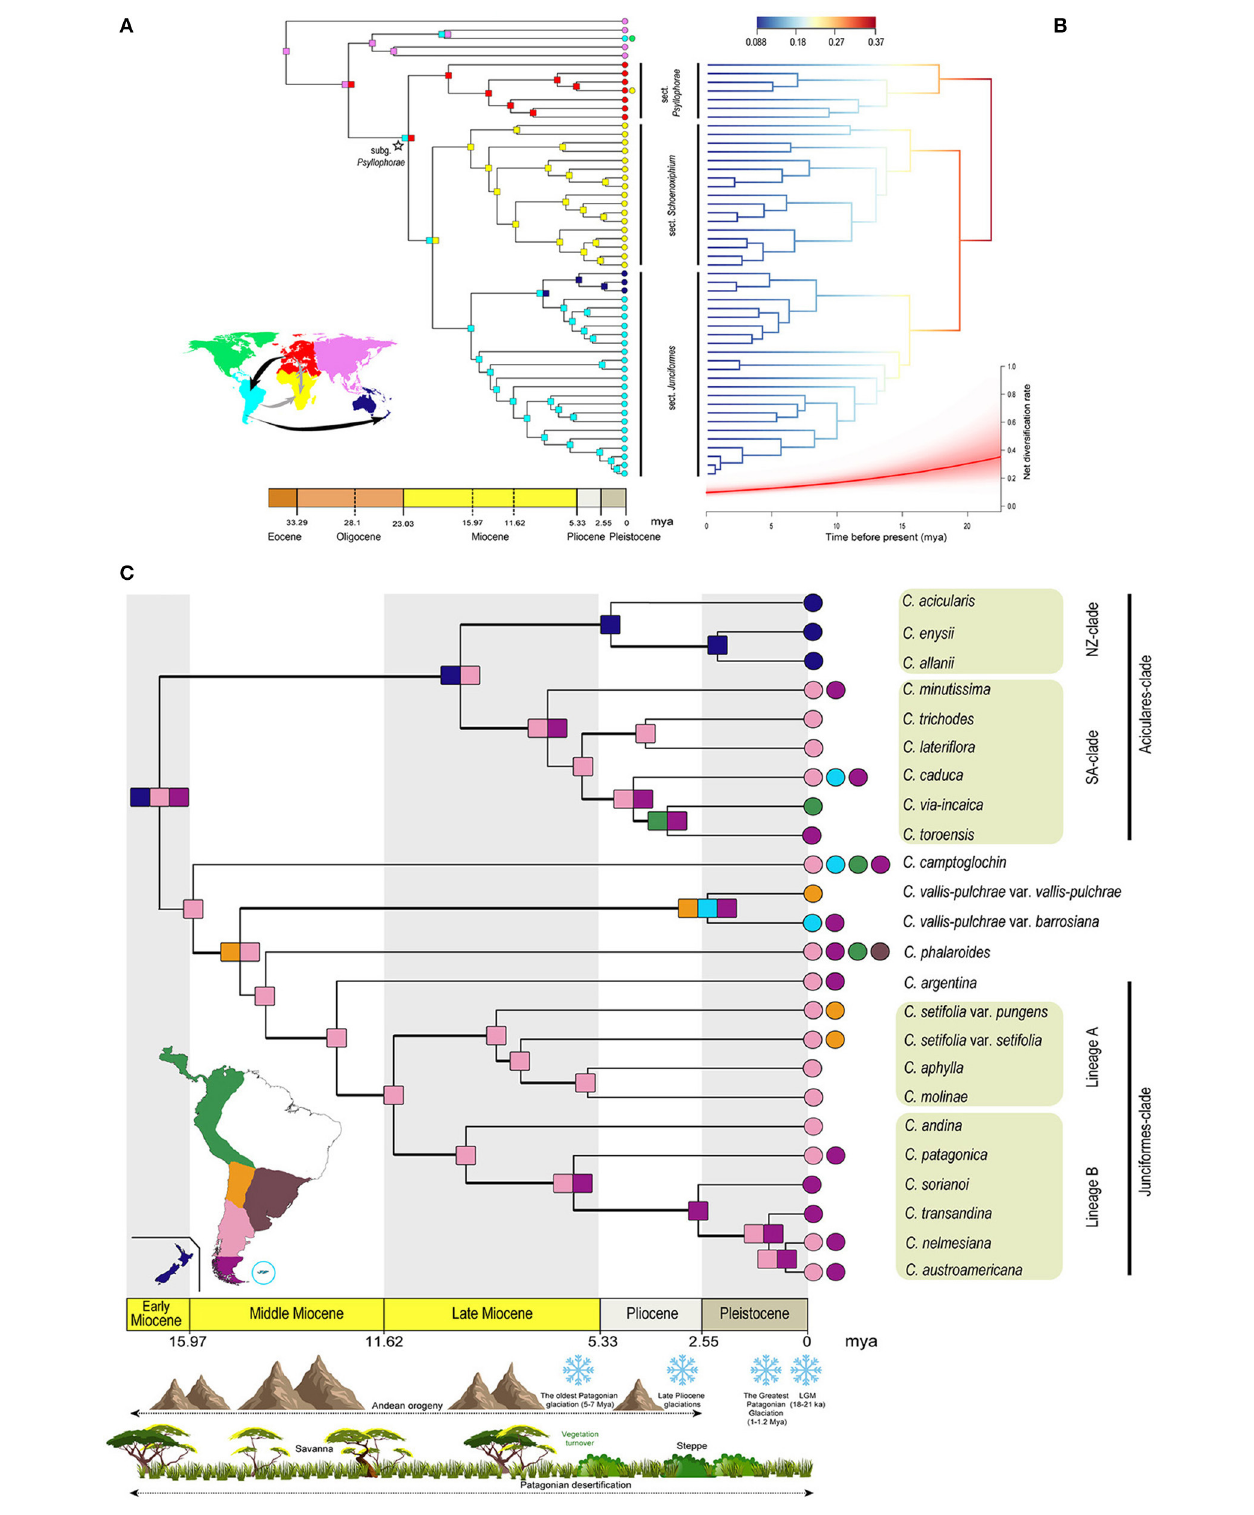
FIGURE 3 | (A) Chronogram based on the dated phylogeny of Carex subg. Psyllophorae. Square nodes and circle terminals with different colors represent the most probable area or combination of areas inferred by the DIVA-like model in the AAR using BioGeoBEARS. Colors are according to the world map representing the regions coded for the biogeographic analysis. Arrows in the map show the direction of migration among the different regions inferred by the AAR. Arrows in black